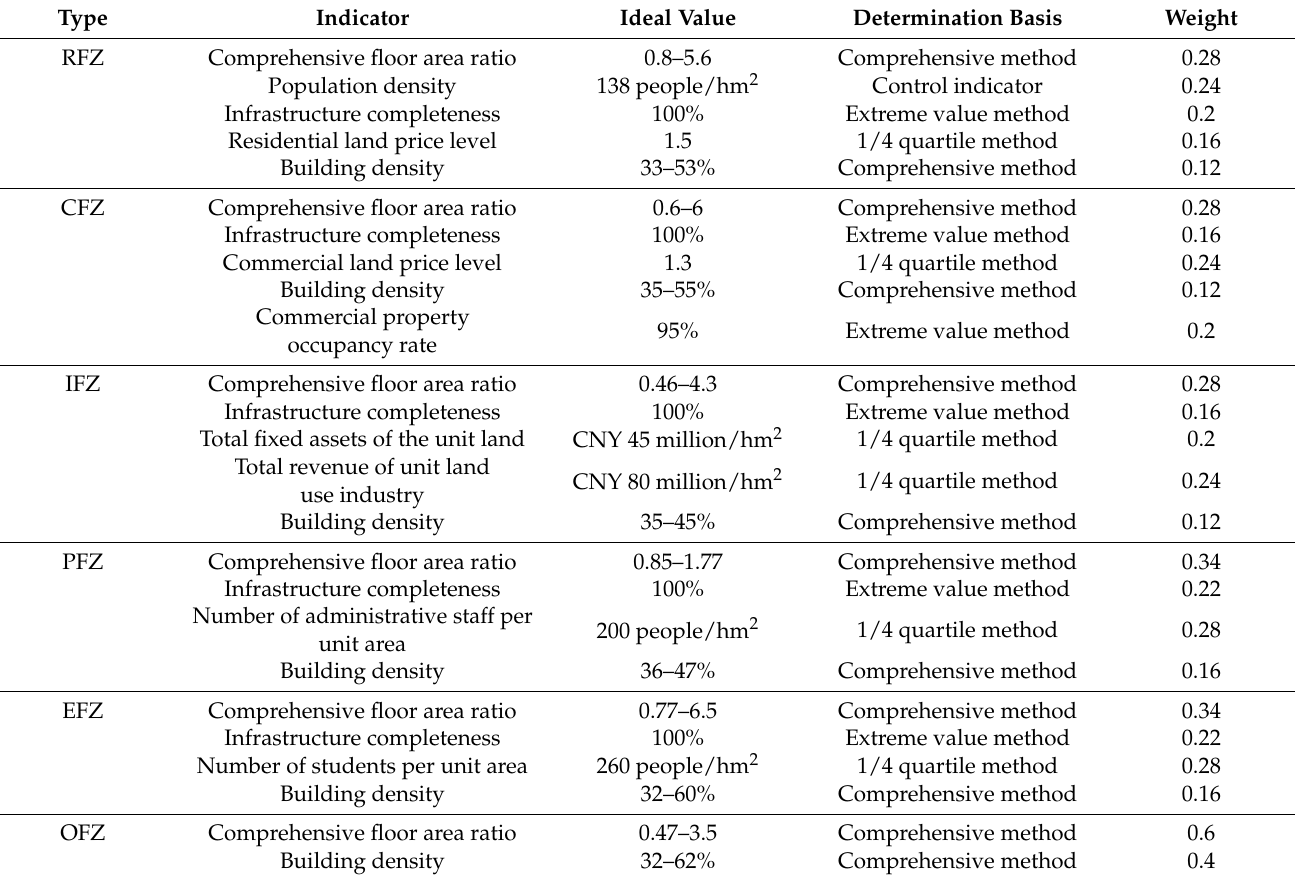
Table 2. Indicator system based on FZ